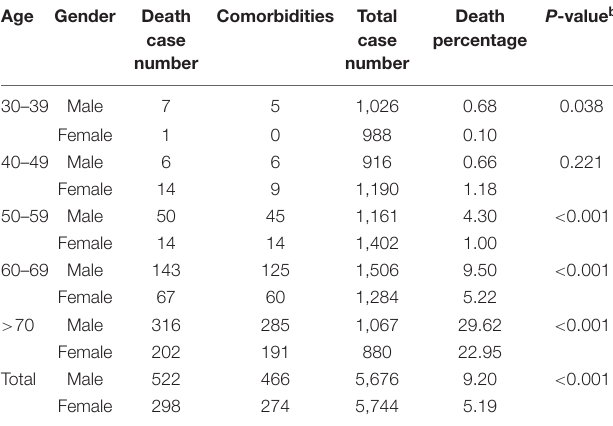
TABLE 4 | Distribution of the age and sex of confirmed COVID-19 patients who died between May and June 2021.